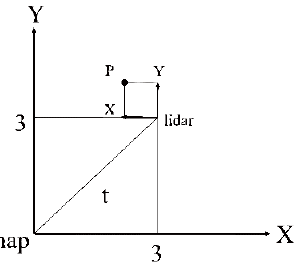
Figure 5. The relationship between the sensor coordinate and the map coordinate system.